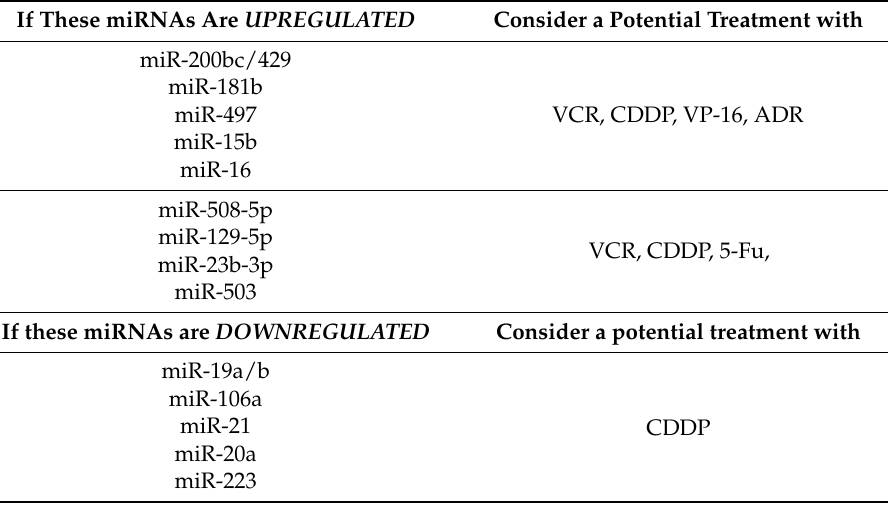
Table 2. MicroRNAs pattern in GC cells and potential